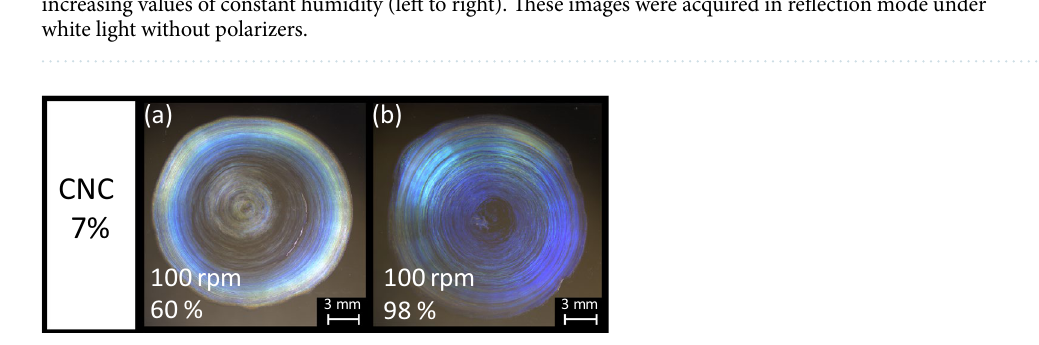
Figure 6. 7% CNC droplet films dried under high humidity of ( a ) 60% and ( b ) 98% while being orbitally shaken anticlockwise. These images were acquired in reflection mode under white light without polarizers.